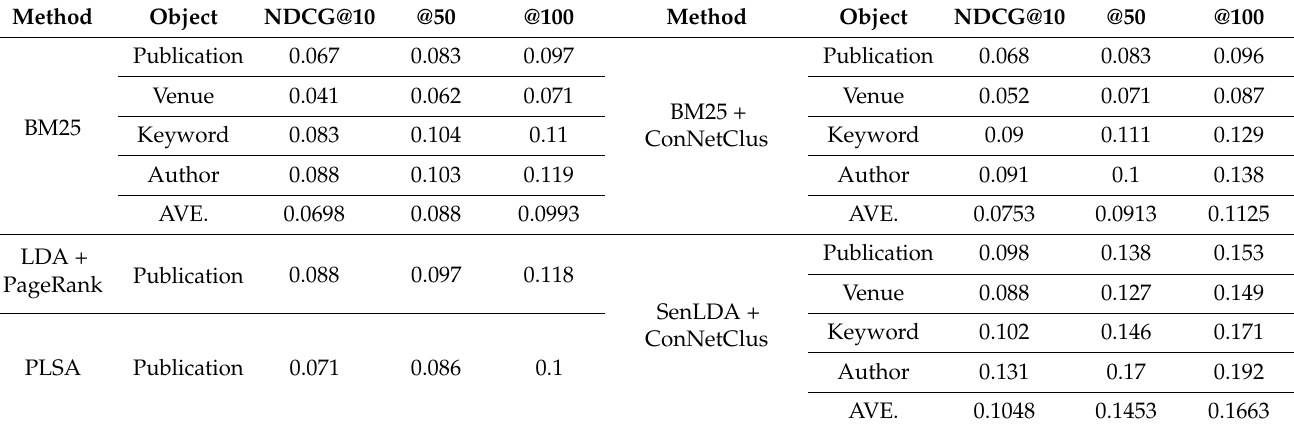
Table 4. Experimental results of